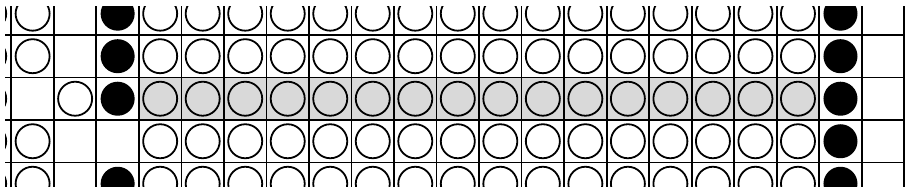
Figure 10. BLACK